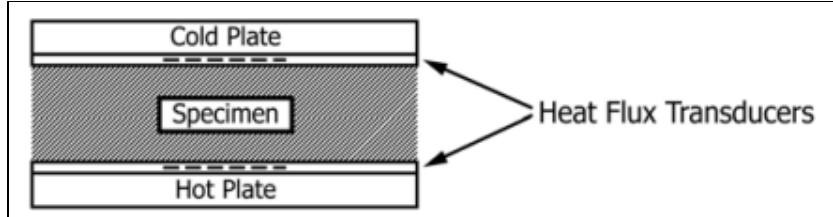
Figure 15. Apparatus with Two Heat Flux Transducers and One Specimen.